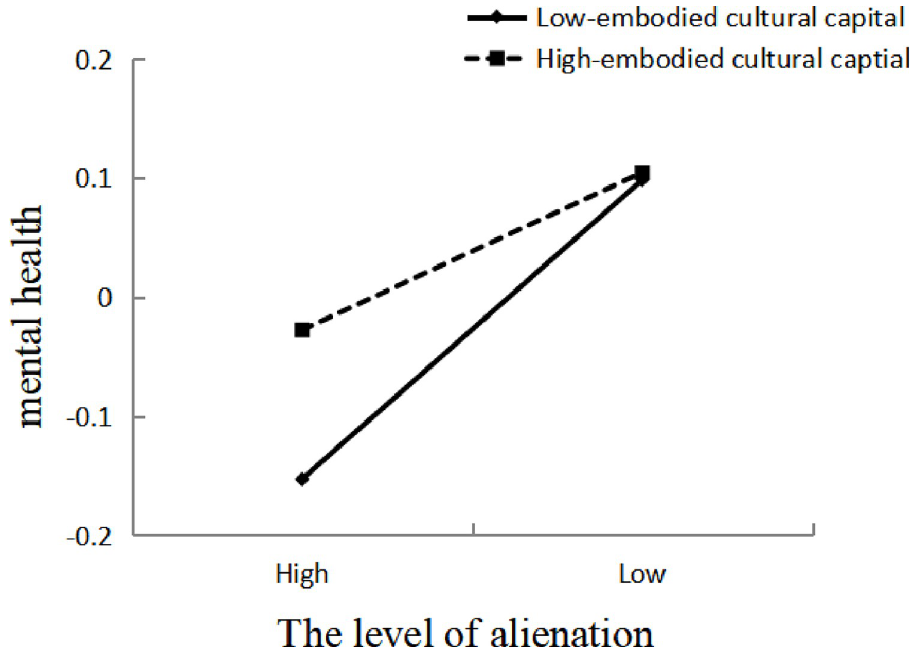
Fig 2. The moderation effect of embodied cultural capital. The level of alienation is divided into high and low, with high representing M + SD , i.e., above the mean, and low representing M - SD , i.e., below the mean, and since the variables are standardized, the mean value is 0, i.e., high and low are ±